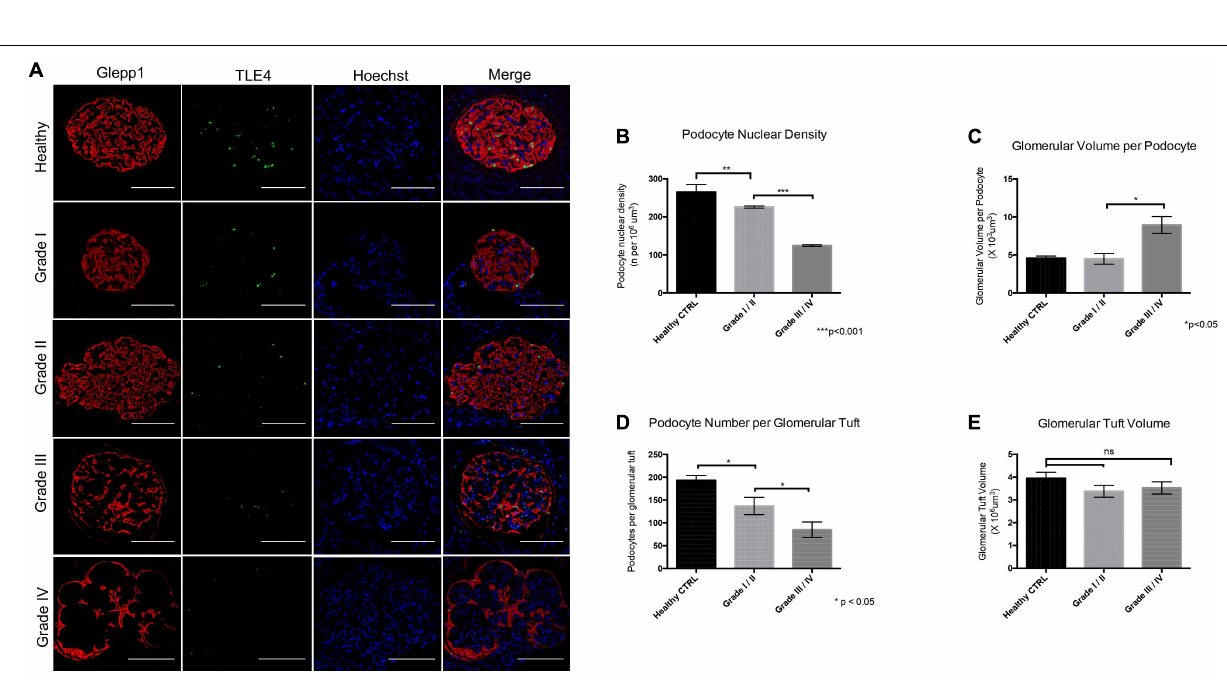
Frontiers in Physiology |